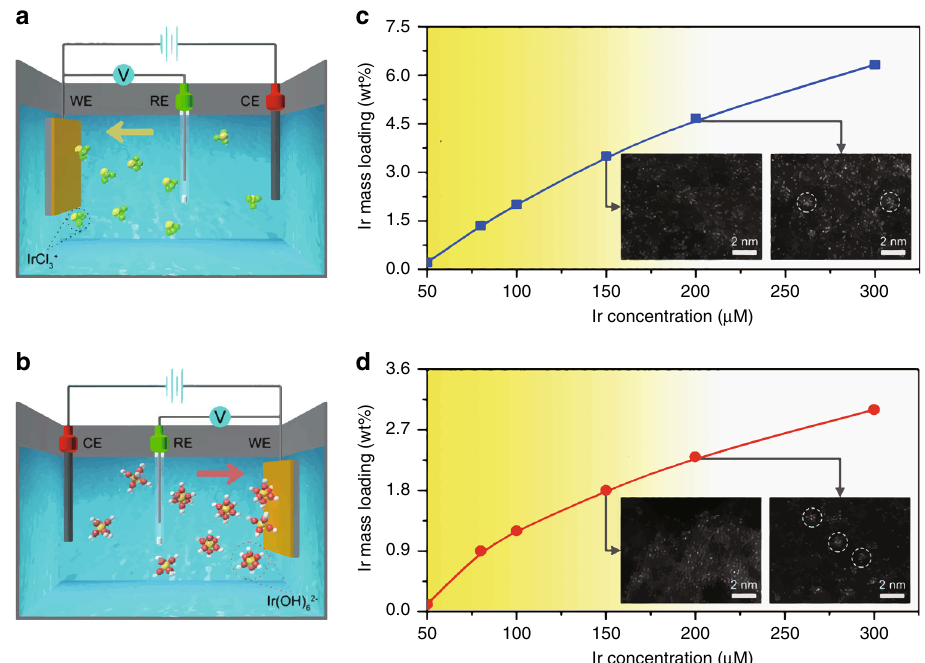
Fig. 2 Electrochemical deposition mechanism. a , b Schematic of cathodic ( a ) and anodic ( b ) deposition of Ir species. The yellow, green, red, and white spheres represent Ir, Cl, O, and H atoms, respectively. A standard three-electrode system was used, with Co(OH) 2 nanosheets loaded on a glassy carbon electrode as the working electrode (WE), a carbon rod as the counter electrode (CE), and an Ag/AgCl electrode as the reference electrode (RE). c , d Ir mass loadings as a function of Ir concentration in the 1 M KOH electrolyte for cathodic ( c ) and anodic ( d ) deposition. The scanning cycle number was kept at ten for cathodic deposition and three for anodic deposition. The color gradient from yellow to white indicates the transition from single atoms to clusters with increasing Ir concentration. The inset images correspond to the HAADF-STEM images of the samples obtained at a certain concentration. The areas in white circles indicate the agglomerations of single atoms to form